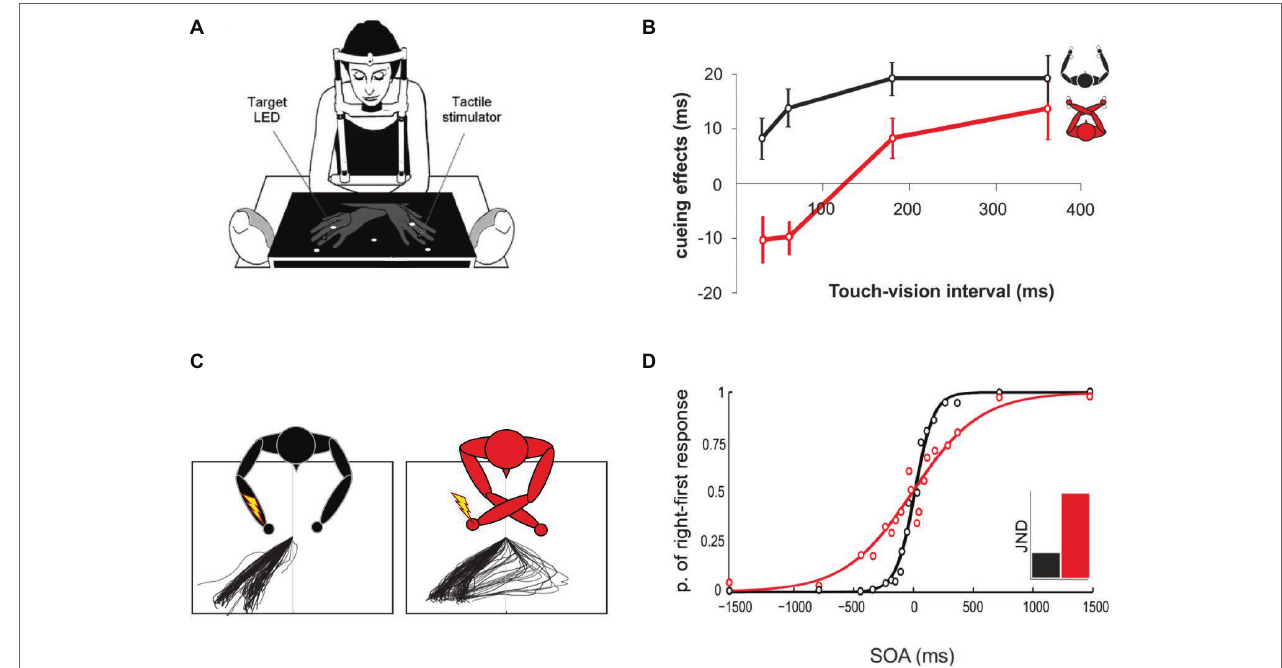
FIGURE 3 | The use of prior information in tactile spatial localization. (A) Data retrieved from Azañón and Soto-Faraco (2008a) study, in which participants were asked to judge as quickly as possible the position of a light flash in the vertical dimension (top-bottom), irrespective of the side of presentation and location of an irrelevant tactile cue. (B) At short cue-target intervals (<60), with arms crossed (red line), targets were faster in opposite cue-target side trials than in same side trials. The pattern reversed after cue-target intervals of about 200 ms, so that tactile cues produced a facilitation of targets presented at the same external location. No differences across intervals were found with uncrossed hands (black line). (C) Data were retrieved from Overvliet et al.’s (2011) study, where participants were asked to direct saccades to a tactile stimulus at the ring finger of one of the two hands, which could be either crossed or uncrossed. Saccades to tactile stimuli when the hands were crossed (right-most panel) were sometimes initiated to the wrong direction and then corrected in-flight, resulting in a turn-around saccade. Adapted from Overvliet et al. (2011). © 2011 by Elsevier. Permission for the use of the image has been obtained from the Elsevier. (D) Figure modified from Heed and Azañón (2014). Typical single participant results of uncrossed and crossed hands temporal order judgment. In this task, two touches are presented at different stimulus onset asynchronies (SOA), and participants are required to move the finger that has been stimulated first, with no time restrain. With uncrossed hands (black line), the psychophysical curve is steeper than with crossed hands (red line), indicating an advantage in performance for the uncrossed posture. The inset illustrates the just noticeable difference (JND) for uncrossed and crossed